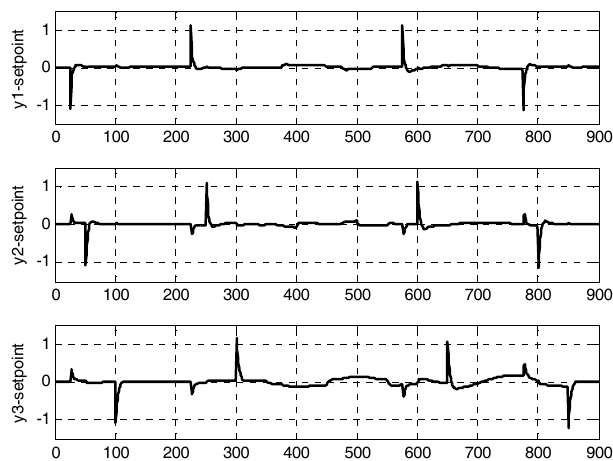
Figure 8. Control results of conventional MPC in dynamic PLS.